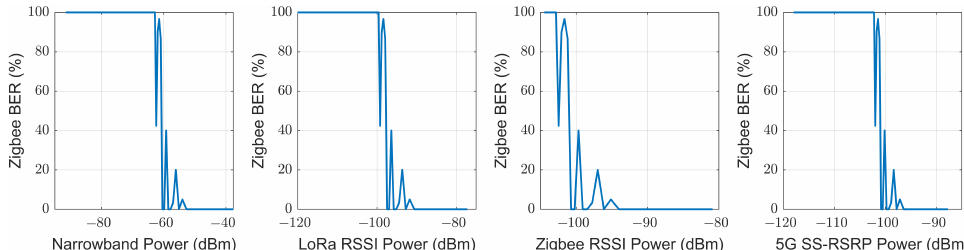
Figure 16. Comparison of empirical Zigbee BER with the estimated received power for each technology.